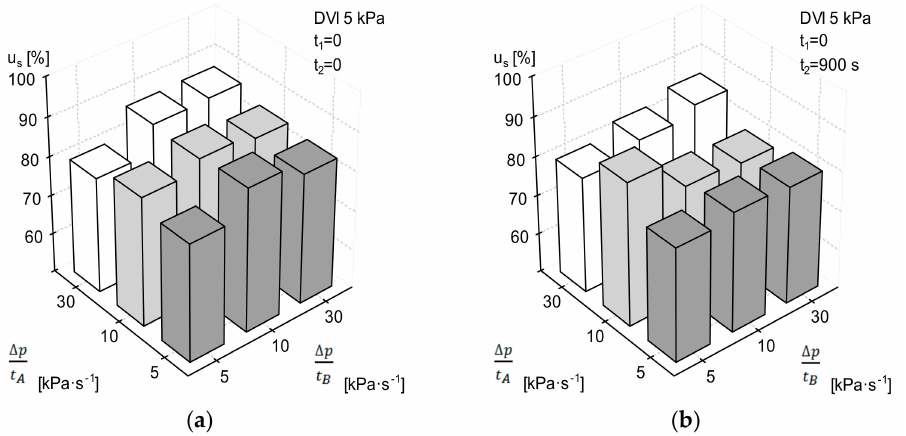
Figure 3. Dependence of the percentage of apple tissue staining u S on the pressure change rate in the dry vacuum impregnation (DVI) cycle for t 1 = 0 and di ff erent values of t 2 : ( a ) t 2 = 0 s, ( b ) t 2 = 900 s.